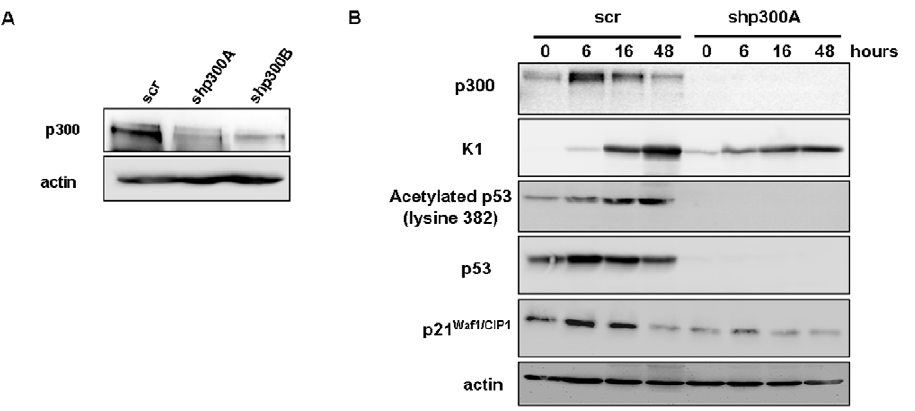
Figure 1. Stable p300 depletion inhibits differentiation. HFKs were induced to differentiate in CaCl 2 medium and harvested at the indicated time points (t=0, 6, 16, 48 hrs). ( A ) Western blot analysis of levels of p300 in control and p300 depleted HFKs using scrambled shRNA (scr) two shRNA molecules (shp300A and shp300B) directed against p300. ( B ) Cells stably expressing p300 targeting shRNAs were induced to differentiate and harvested at the indicated time points. Western blot analysis indicates that knocking down p300 dramatically reduces the p300 mediated acetylation and expression of p53. There is also a decrease in p21 Waf1/CIP1 and K1 levels in p300 depleted HFKs. The results shown are representative of three independent experiments.